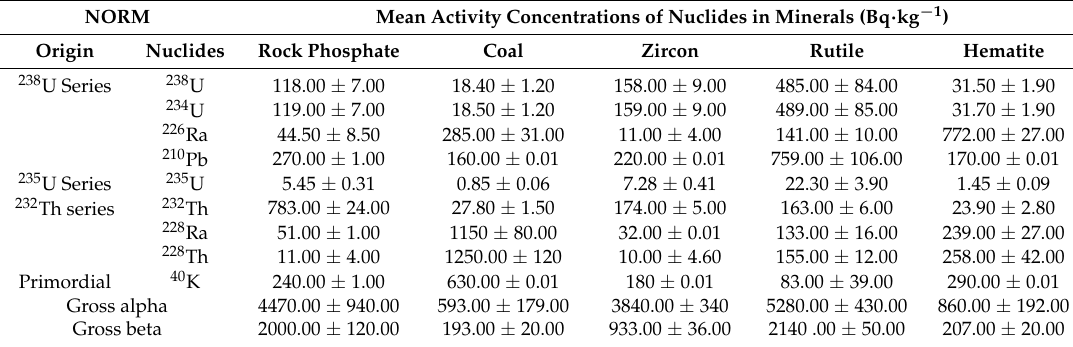
Table 2. Average concentrations of radionuclides in representative mineral samples.